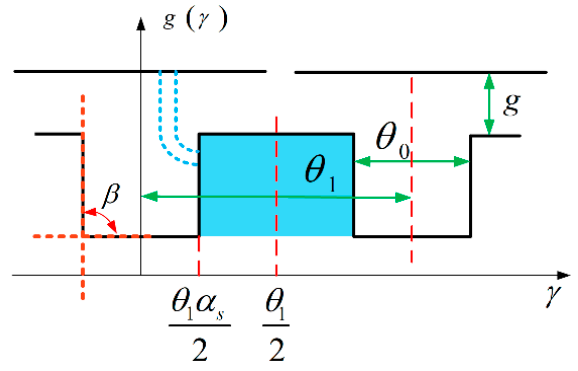
Figure 9. Distribution of g ( γ )